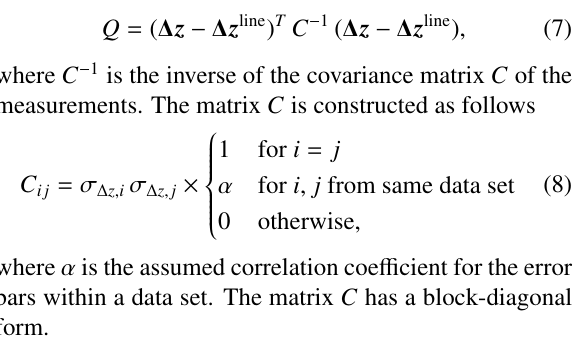
they are not energy-scale corrected and not directly com- parable to the other